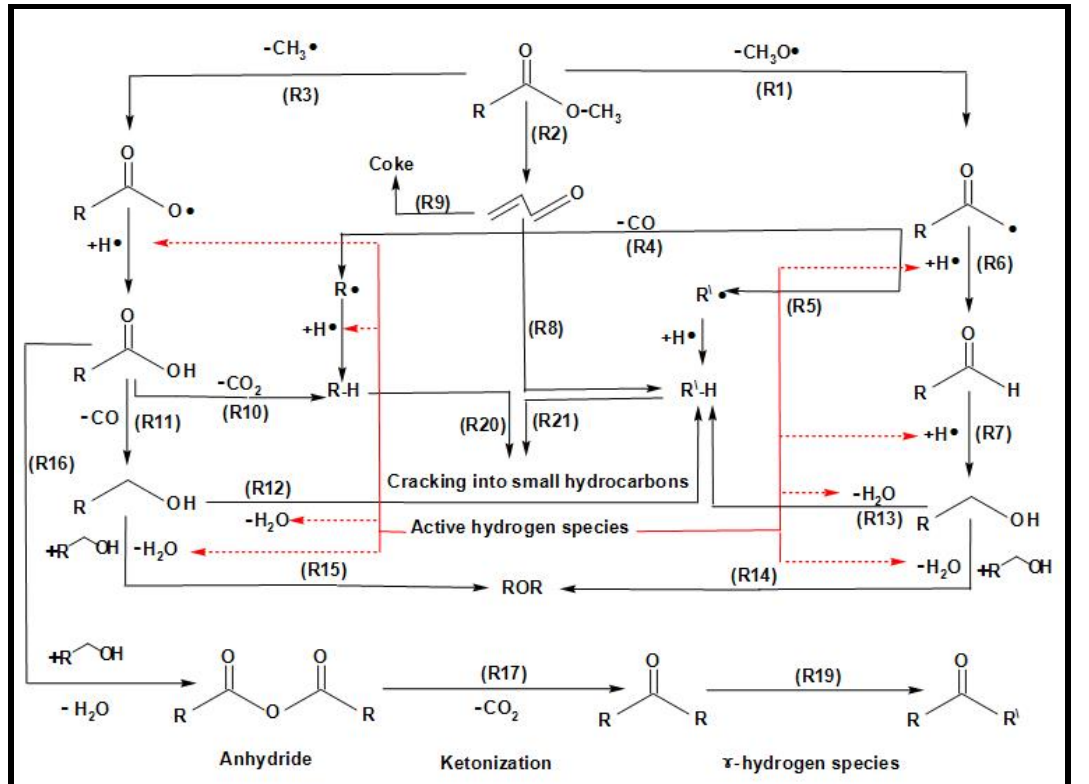
Figure 13. Proposed overall reaction pathways for the catalytic cracking of the algal HO for parent HZSM-5 and Lanthanum-Cerium modified